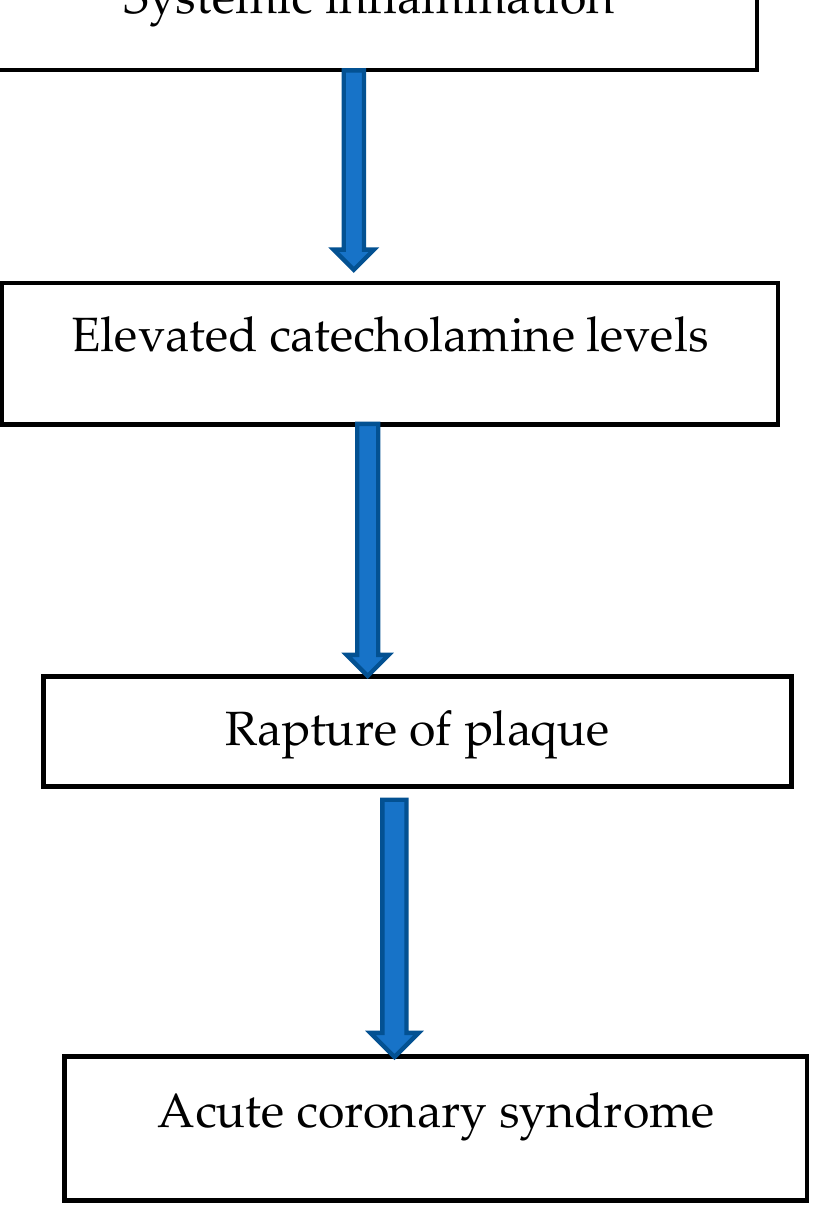
Figure 4. Diagrammatic illustration of plaque alteration mechanism.